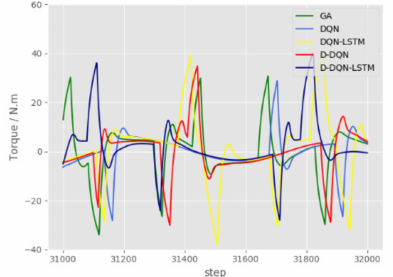
Figure 15. Torque curve between 31,000 and 32,000 in a static environment.